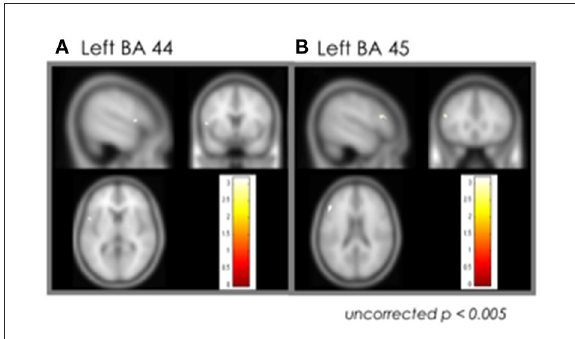
FIGURE3 Effect of the cTBS: ROI analysis. (A) Left BA 44. (B) Left BA 45. cTBS, continuous theta-burst stimulation; BA, Brodmann area.